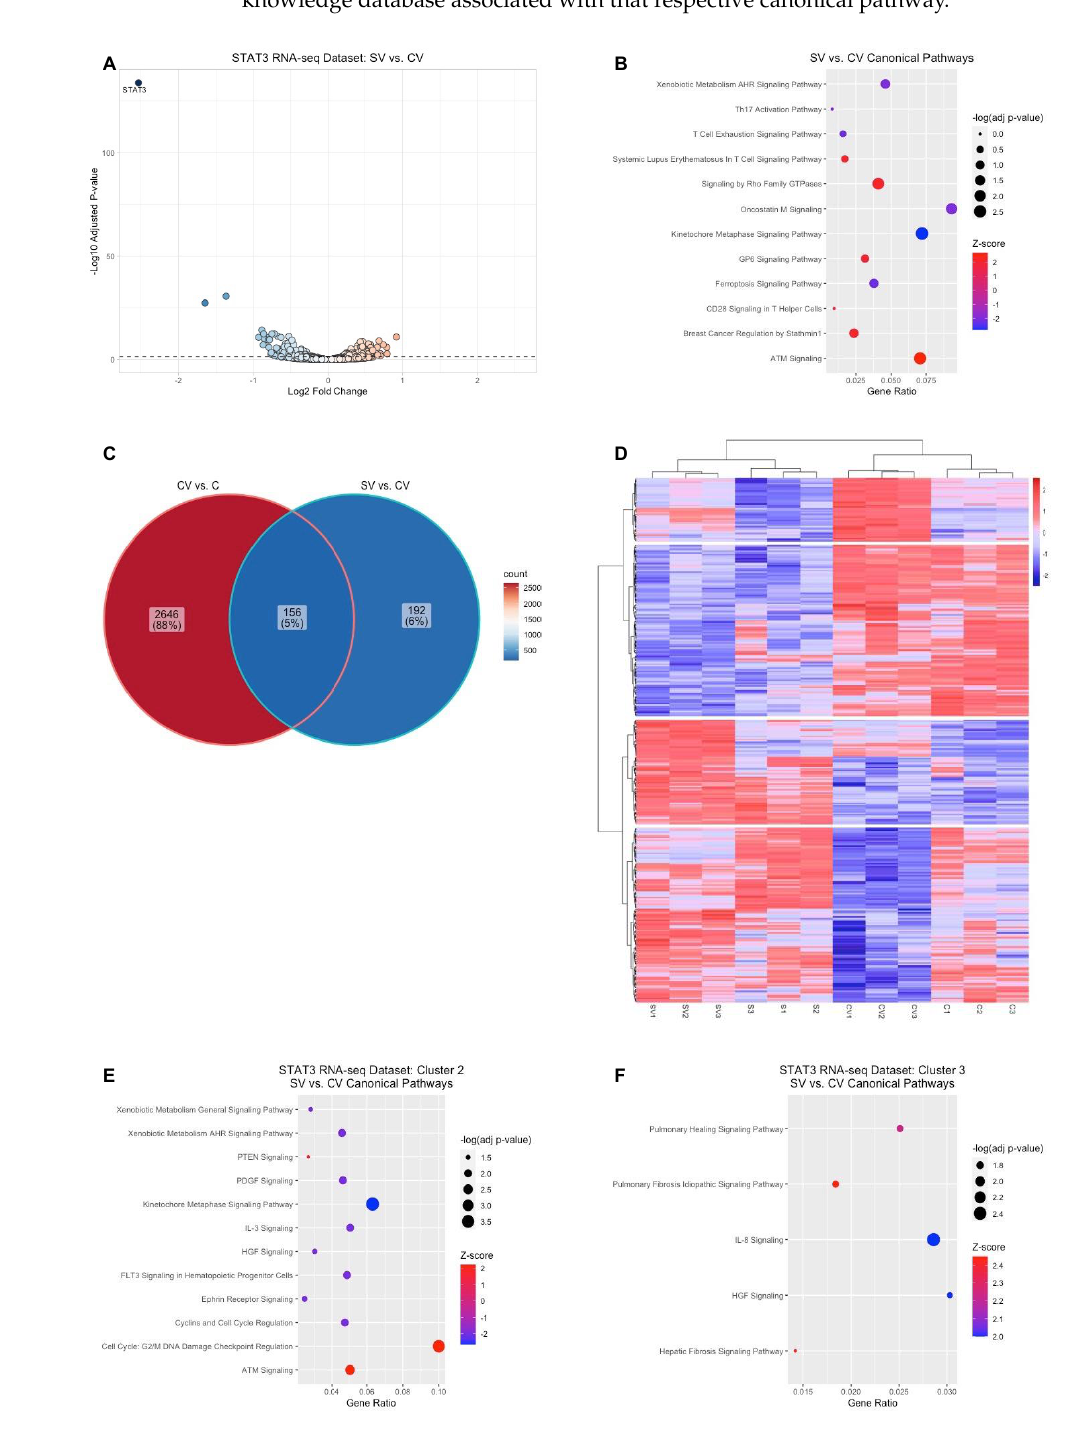
Figure 4. STAT3-mediated gene regulation and pathway enrichment in HRMECs. ( A ) Visualization of the VEGF-induced STAT3–mediated genes (VEGF-treated STAT3 siRNA-transfected HRMECs